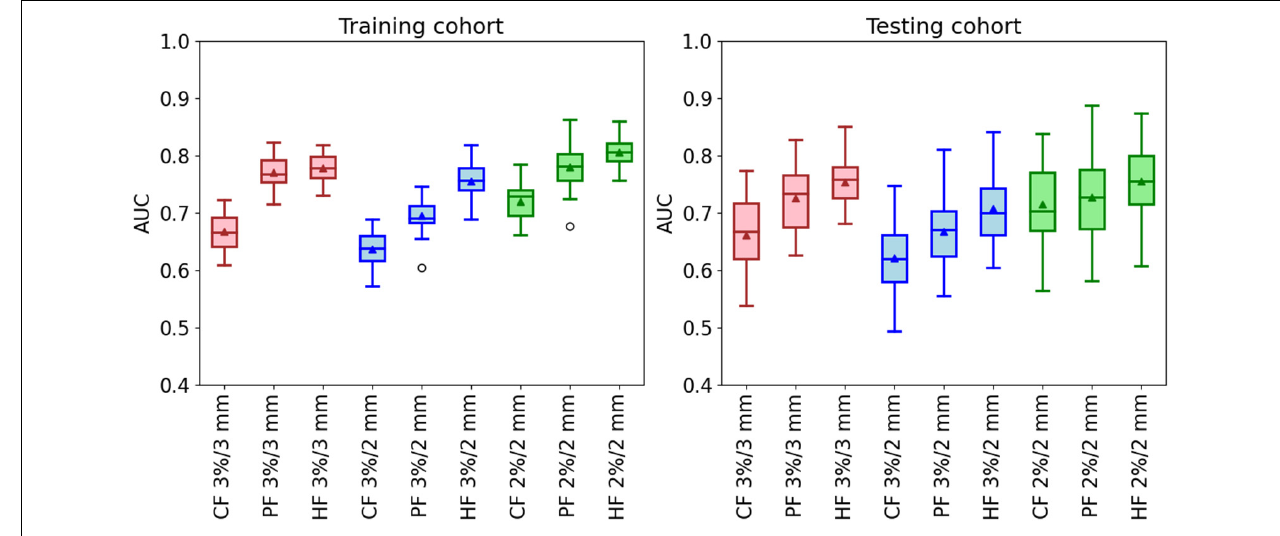
FIGURE 5 | The AUC of the classification model in the training and testing cohorts by using three kinds of feature modalities in the conditions of the three gamma criteria. The used action limit is 99% for 3%/3 mm, 98% for 3%/2 mm, and 95% for 2%/2